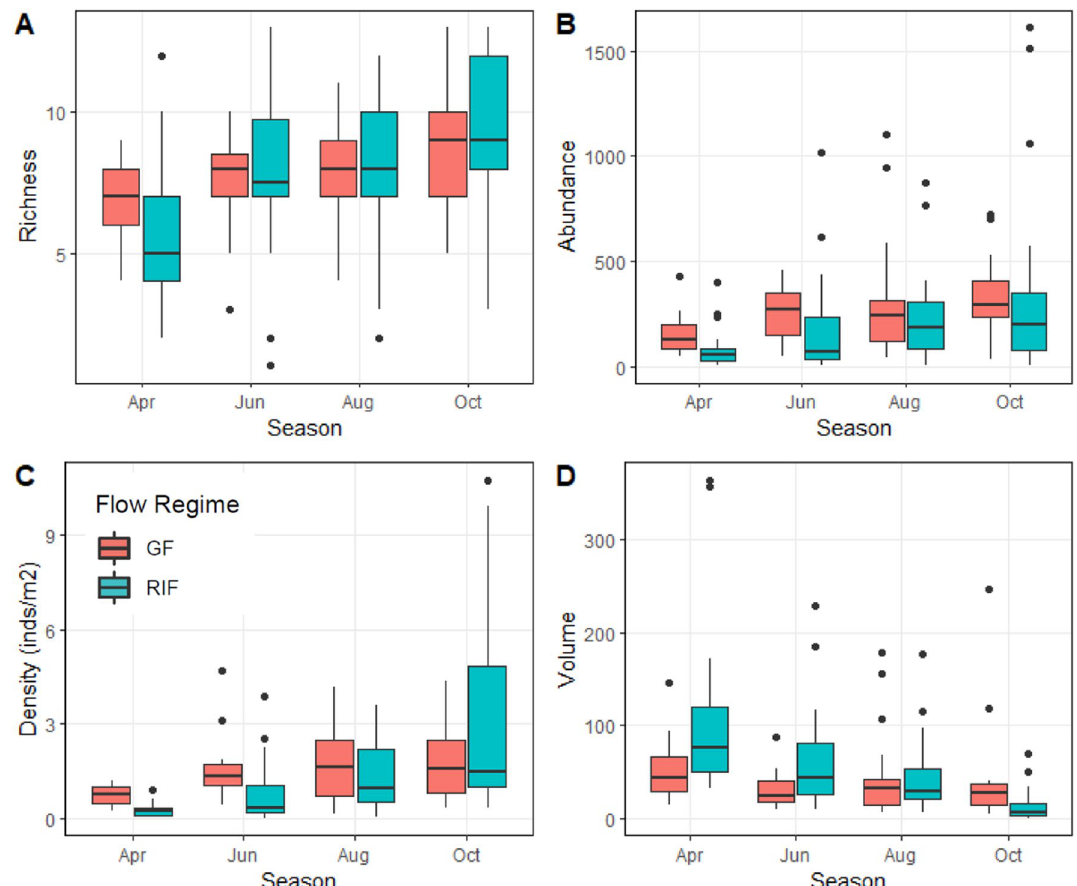
Figure 3. Boxplots of fish species richness ( A ), fish total abundance ( B ), fish total density ( C ) and ( D ) habitat volume (m 3 ) in Runoff/Intermittent Flashy (RIF) and Groundwater Flashy (GF) streams in 2002. Box indicates median and interquartile range, whiskers show range, and dots indicates outliers (1.5 × interquartile range). Figure produced with R 34